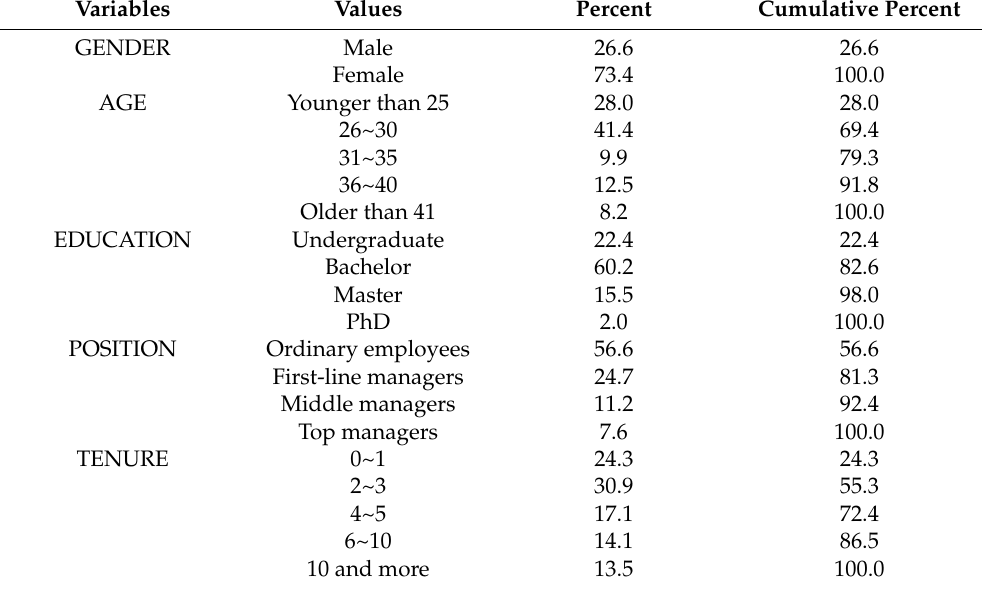
Table 1. Profile of the